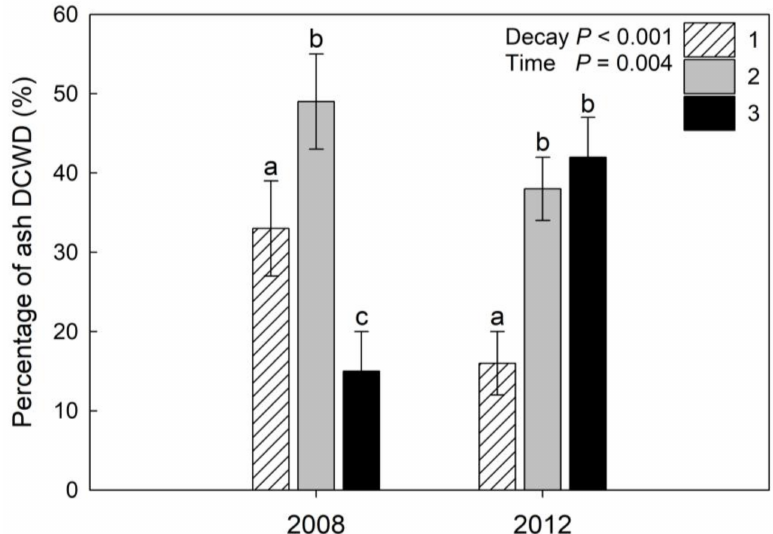
Figure 4. Average percentage ( ± SE) of downed coarse woody debris (DCWD) that was ash by year (2008 and 2012) for decay classes 1 (white bars), 2 (gray bars), and 3 (black bars) in 16 forest stands in the Upper Huron River watershed in southeastern Michigan, USA. Different letters indicate a significant difference at α =